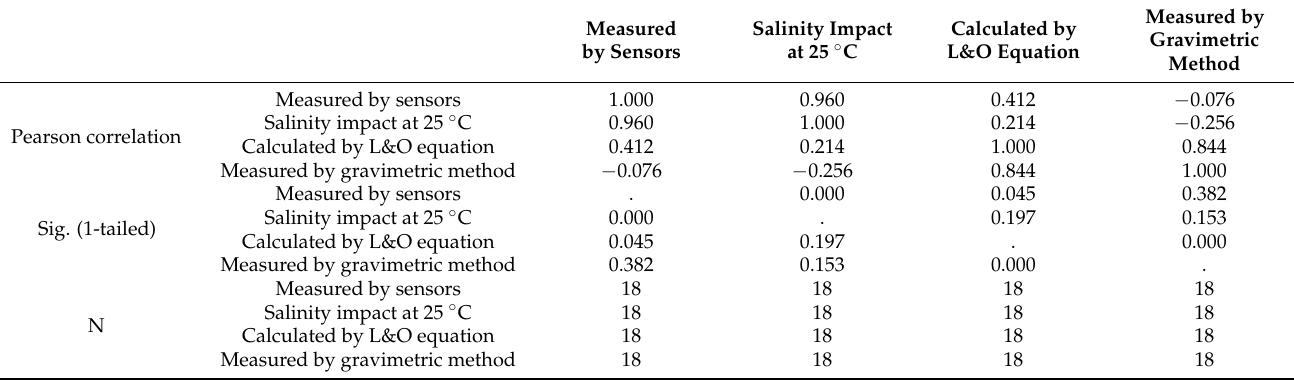
Table 11. Correlation between salinity levels, average sensor readings of VWC, actual VWC values, and calculated values of VWC by proposed L&O